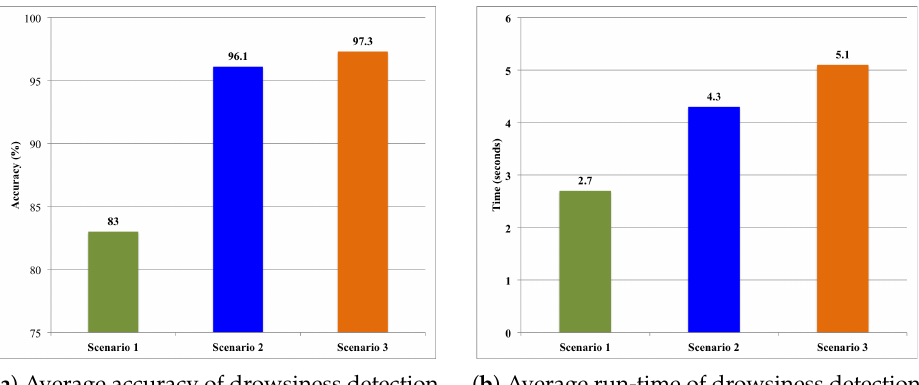
Figure 16. Average accuracy and run-time of drowsiness detection in testing